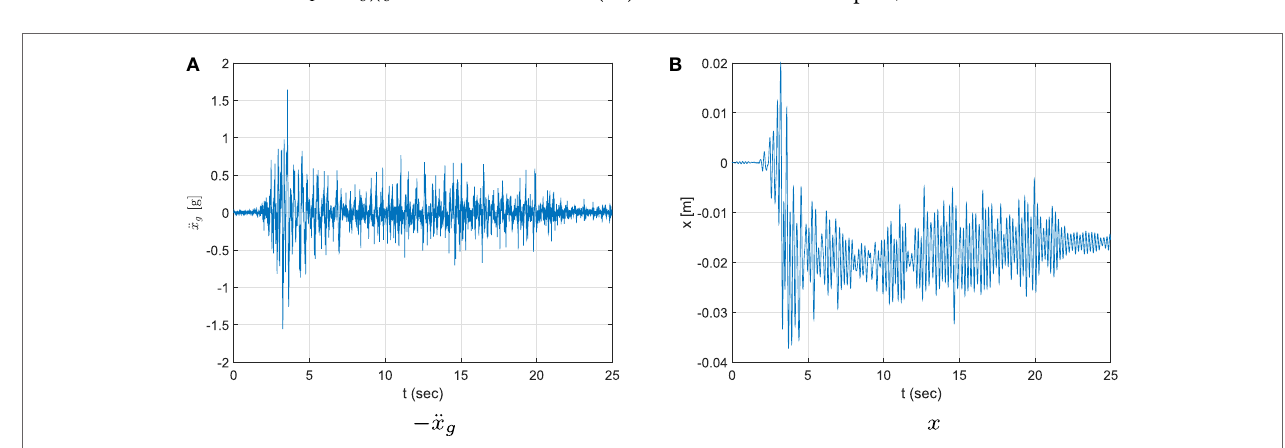
FIGURE 3 | (A) Ground acceleration (B) relative